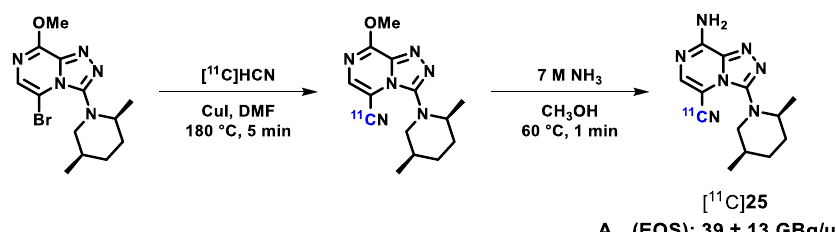
Figure 5. Molecular structures and IC 50 or EC 50 values for the PDE7 isoforms of ([ 18 F]) 22 and ([ 11 C]) 23 [96,97], ([ 3 H]) 24 [98], and ([ 11 C]) 25